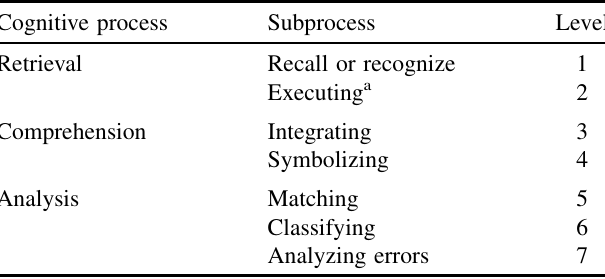
TABLE II. A limited hierarchy of the cognitive processes described by the TIPP. Most problems in a standard physics textbook require comprehension-integrating as the highest cog- nitive process required involving declarative knowledge and retrieval-executing as the highest cognitive process required involving procedural knowledge [9]. The level indicates the numeric value we scored the highest cognitive process required by each problem.